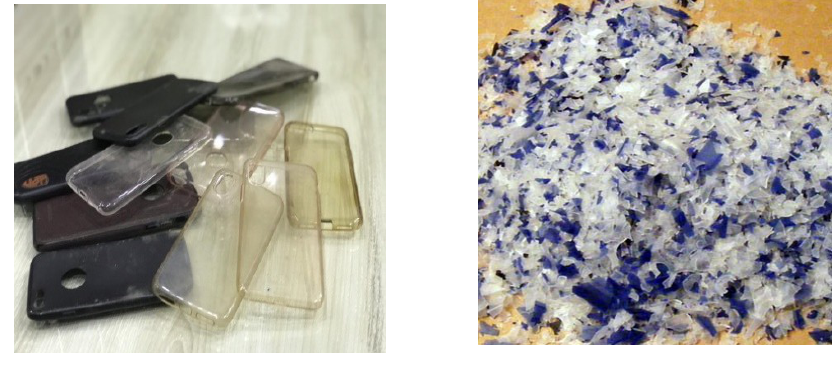
Figure 1. Silicon mobile cover waste .